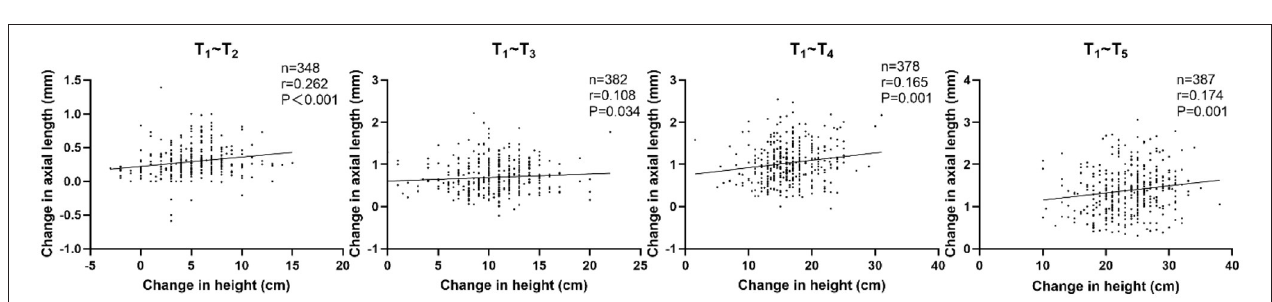
FIGURE 3 | Correlation between changes in height and changes in axial length in all